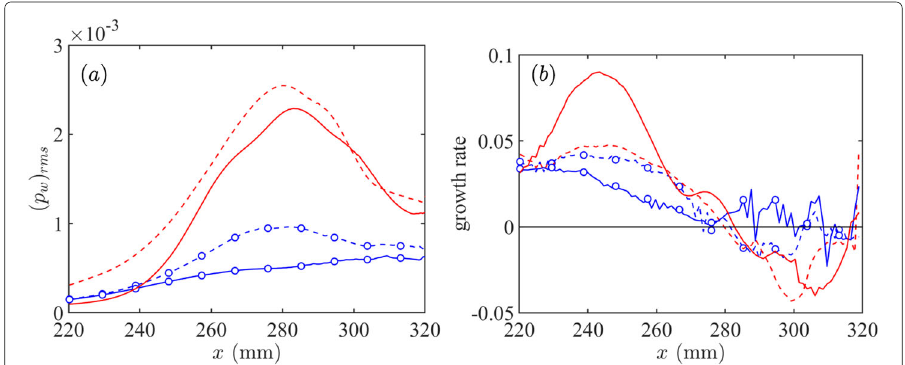
Fig. 9 Axial evolution of ( p w ) rms ( a ) and its growth rate ( b ) along the stationary crossflow vortex trajectories V1 (solid) and V2 (dashed). Lines with and without symbols are respectively for the low- and high-frequency wall pressure